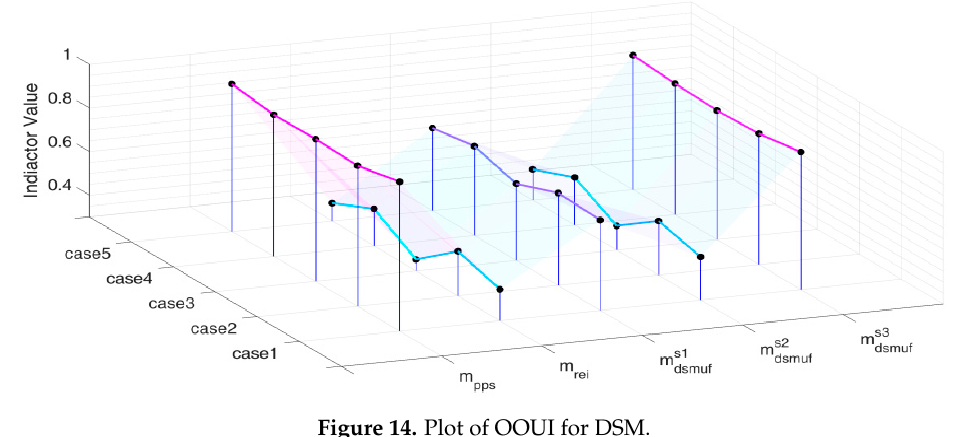
Figure 14. Plot of OOUI for DSM.